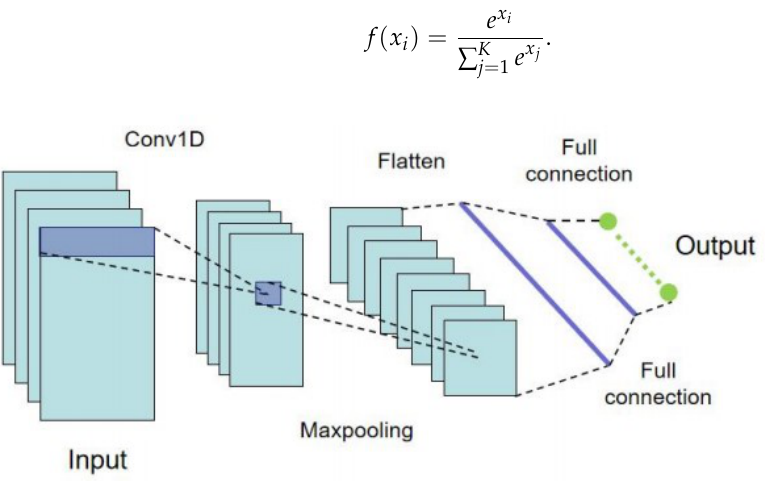
Figure 18. Proposed CNN model for diagnosis the fault causes of permanent magnet synchronous motor